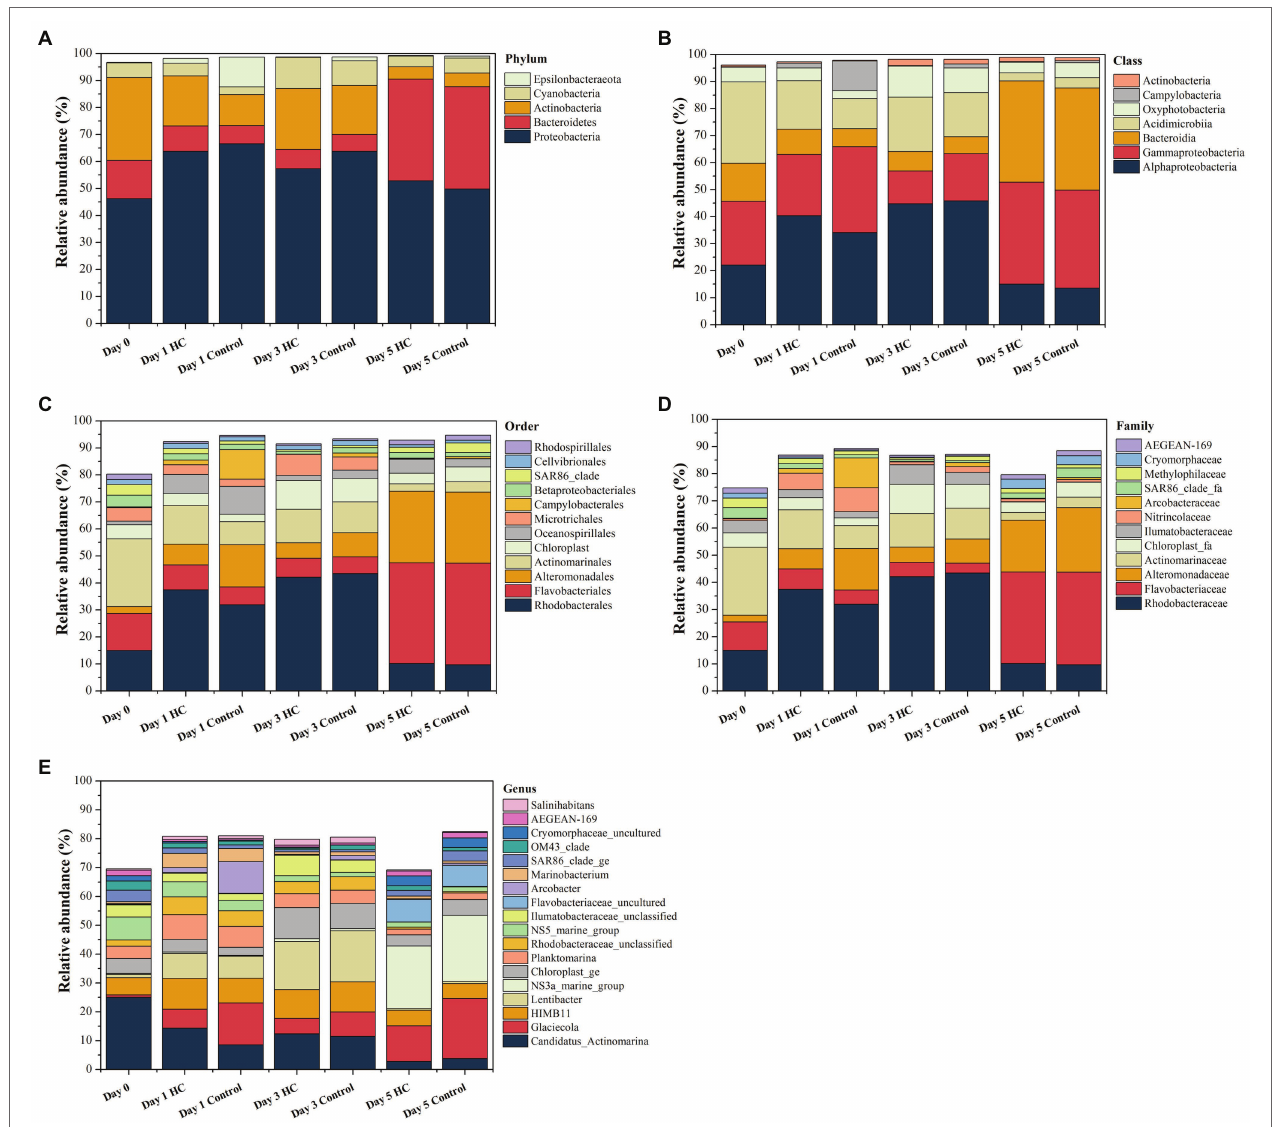
FIGURE 5 | Composition of bacterioplankton community at the phylum (A) , class (B) , order (C) , family (D), and genus (E) levels in elevated p CO 2 (HC, about 1,000 μ atm) and ambient p CO 2 (Control, about 380–410 μ atm) conditions during incubation. Charts show relative abundance of taxa present at